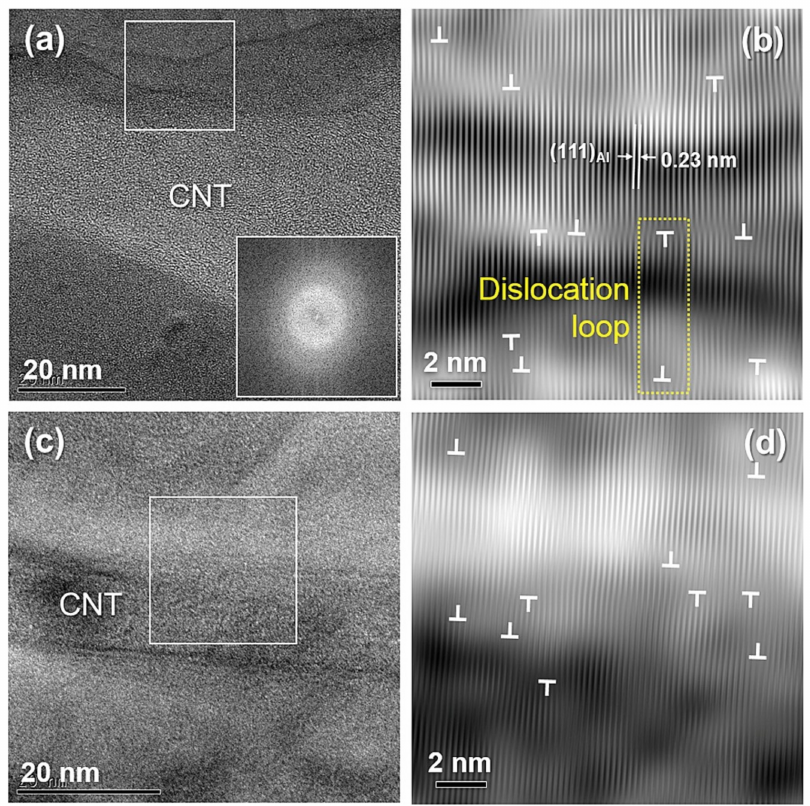
Figure 18. TEM analyses of Al/1%CNTs@BM24h ( a , b ) and Al/1%CNTs@MC ( c , d ) composites after tensile tests. ( a ) and ( c ) are high-resolution TEM images. ( b ) and ( d ) are inverse FFT images of the box areas in ( a ) and ( c ), respectively. Reproduced from [99] with permission from Elsevier, 2017.